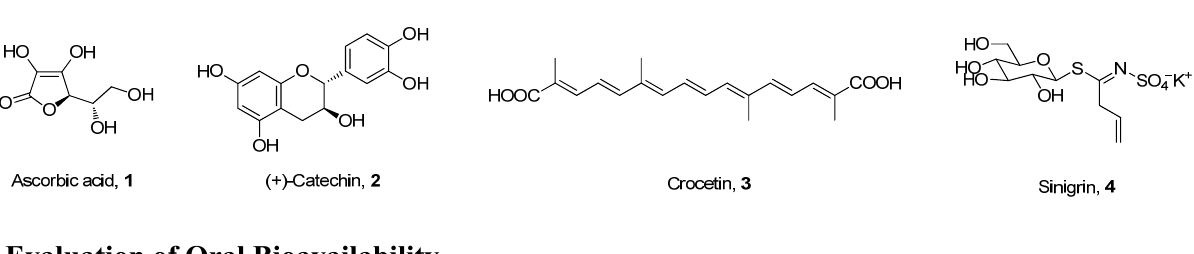
Figure 1. Representative orally bioavailable natural antioxidants and antioxidant modulators with diverse chemical